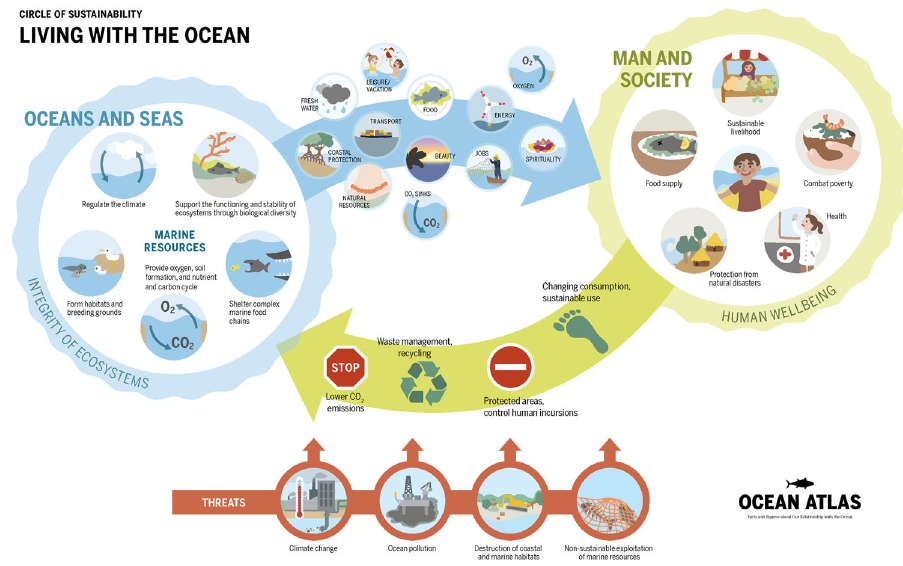
Fig. 1 Human – ocean interactions highlighting ocean ecosystem services and their threads (taken from Ocean Atlas, 2017 12 )